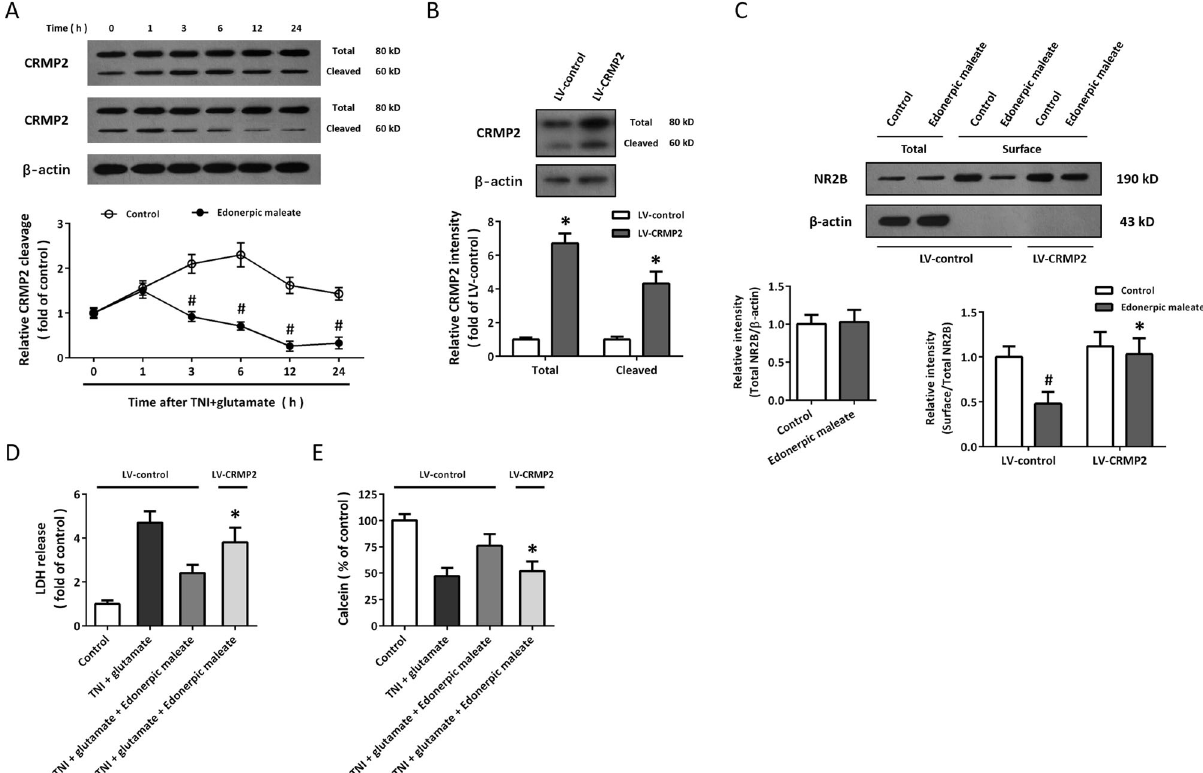
Fig. 3 Role of CRMP2-mediated mechanism in edonerpic maleate-induced protection. A Edonerpic maleate attenuated CRMP2 cleavage within 24 h following TNI and glutamate treatment. B Transfection with LV-CRMP2 increased total- and cleaved CRMP2 expression. C Overexpression of CRMP2 reversed the effect of edonerpic maleate on surface NR2B expression. D , E LDH release assay ( D ) and calcein signal assay ( E ) showed that overexpression of CRMP2 attenuated the protective effects of edonerpic maleate against TNI and glutamate. Error bars indicate SEM. # p < 0.05 vs. Control. * p < 0.05 vs .